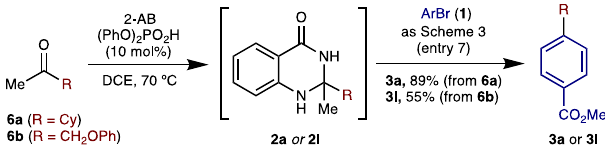
Fig. 3 Telescoping the formation of dihydroquinazolinones from ketone congeners. Using ketone (0.63 mmol) and 2- aminobenzamide (0.6 mmol) to form dihydroquinazolinone, then as Table 1 entry 7 using aryl bromide (0.20 mmol). Yields denote isolated